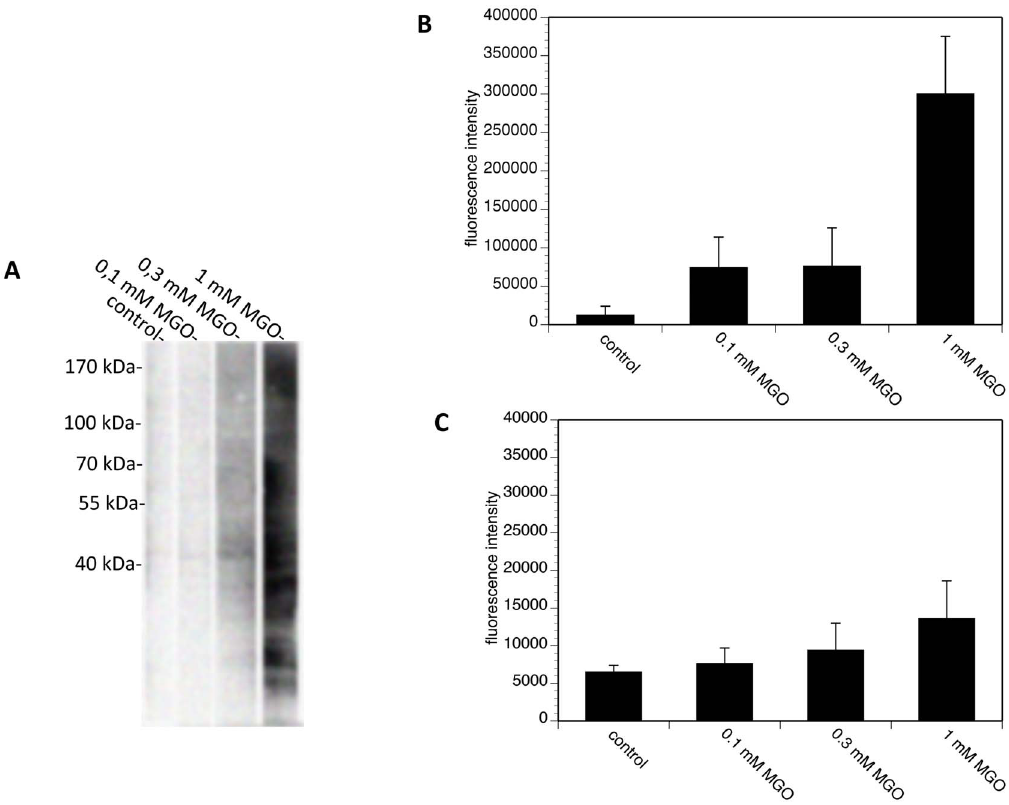
Figure 5. AGE-modification of PC12 cells using MGO. PC12 cells were incubated with PBS, 0.1 mM MGO, 0.3 mM MGO or 1.0 mM MGO for 4 hours. A. Washed cells were solubilized and subjected to SDS-gel electrophoresis. Proteins were blotted and detected using monoclonal CML26 antibody B&C. Permeabilized (B) and non-permeabilized (C) were analyzed by flow cytometry using monoclonal CML26 antibody.